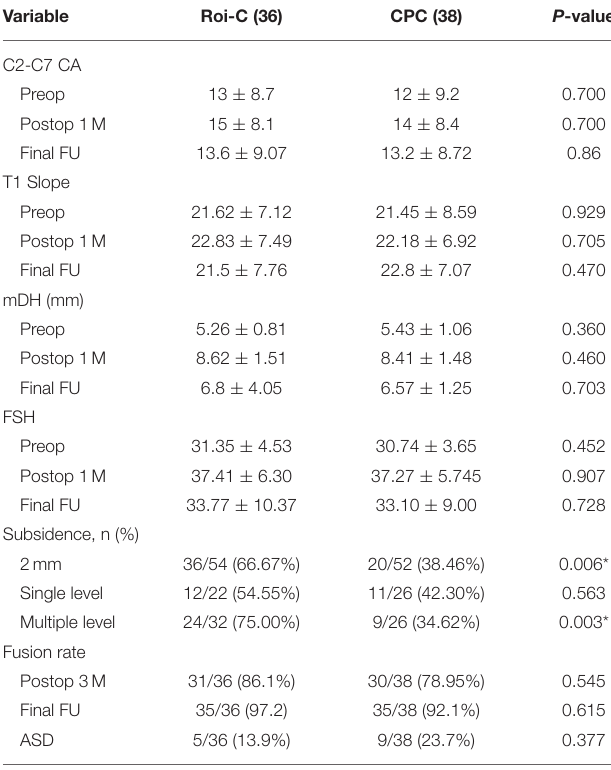
TABLE 3 | Radiographic outcomes between ROI-C group and CPC